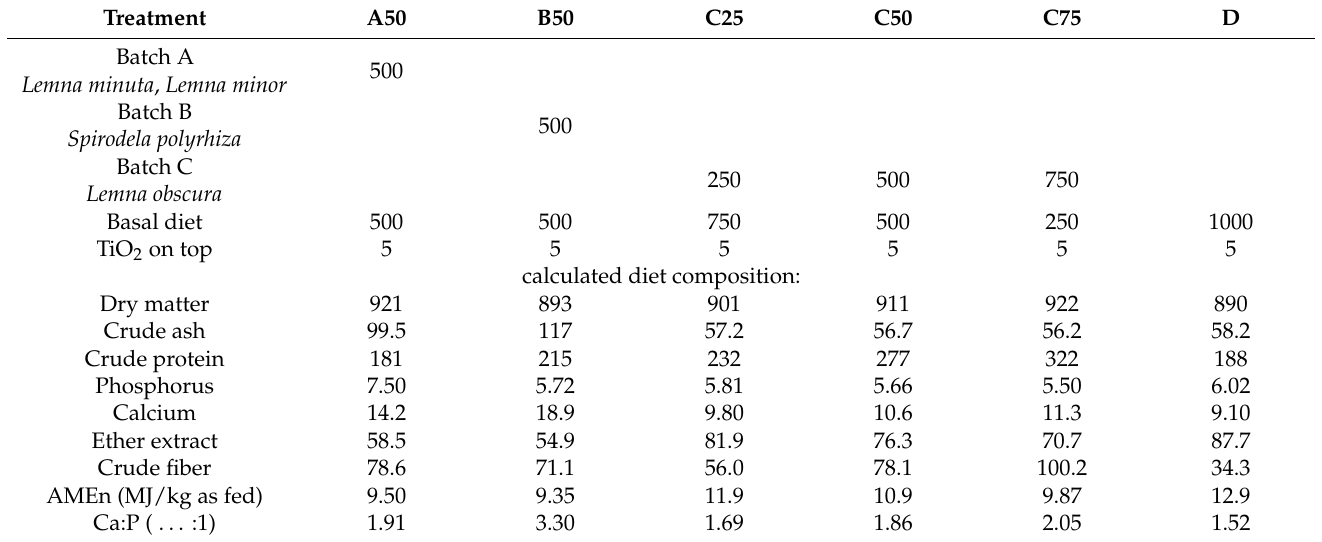
Table 2. Botanical and chemical composition of the experimental diets (g/kg as fed except where